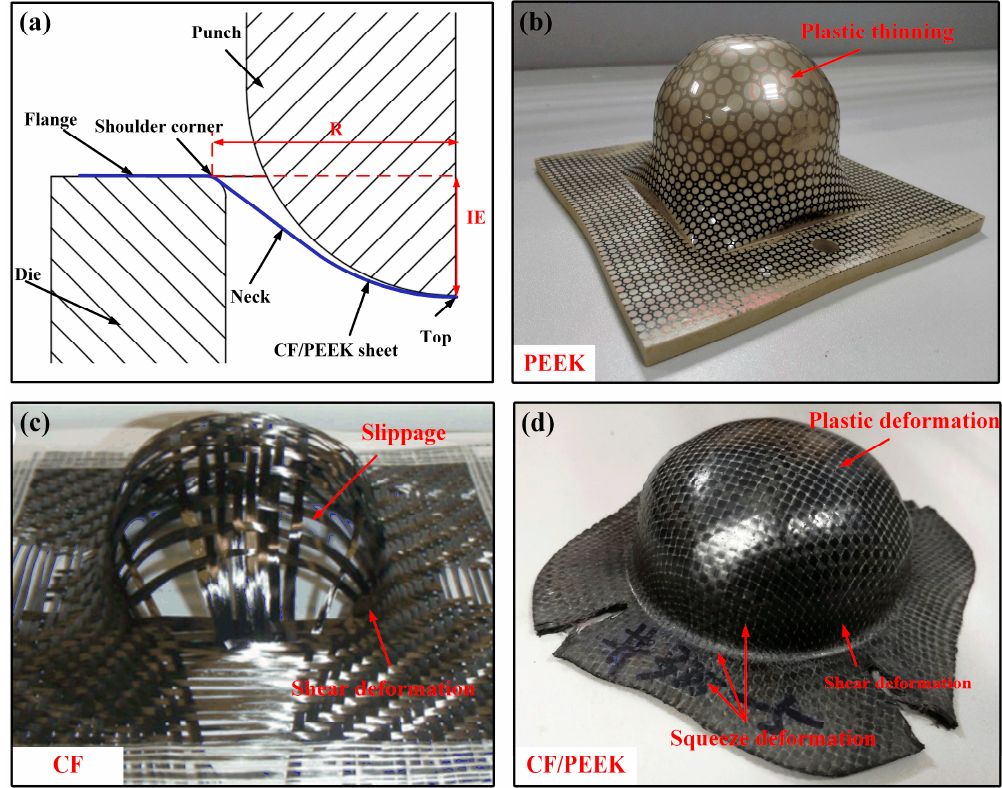
Figure 15. Erichsen test results of different materials at elevated temperature: ( a ) schematic of the Erichsen test, ( b ) PEEK tested, ( c ) CF, and ( d ) CF/PEEK.